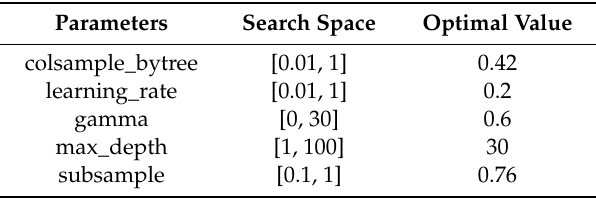
Table 9. Search space and optimal value of hyperparameters.